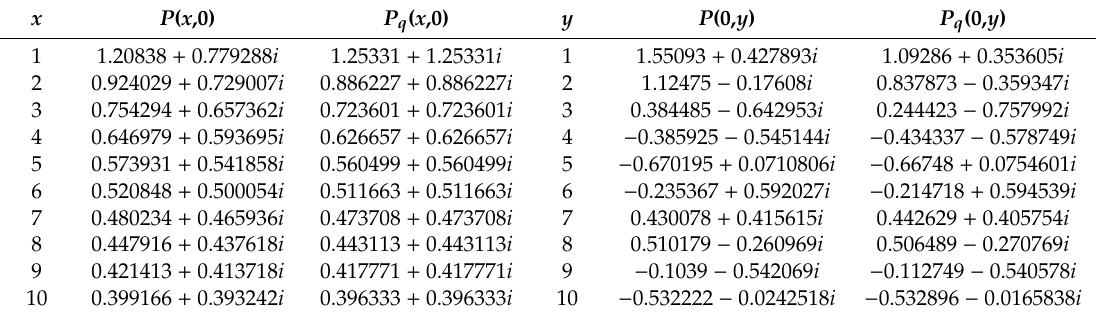
Figure 2. Function x ∈ [ 0,10 ] and y ∈ [ 0,10 ] . Table 2. Comparison values of P ( x , y ) and approximate function P q ( x , y ) for y = 0 and x =